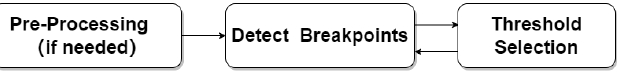
Figure 15. Workflow3: Segmentation